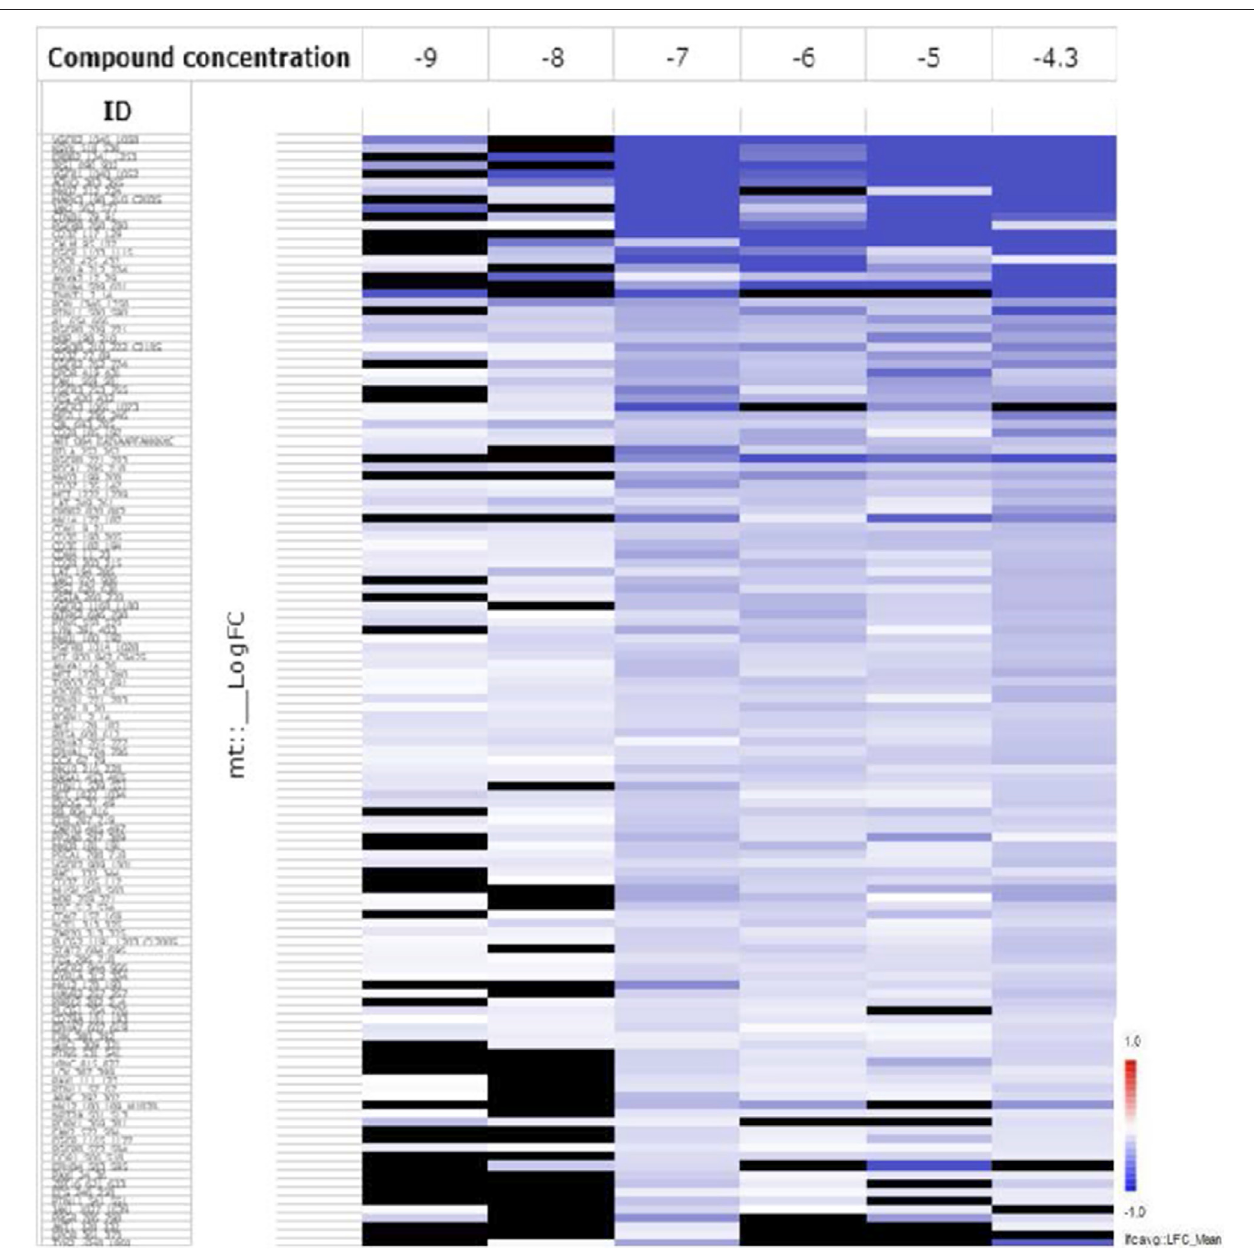
FIGURE5| TheLFCheatmapforpeptidesshowsthevaluesofdifferentiallyinhibited phosphorylated peptides (KIM-161vs.DMSOcontrol).Thetreatment effects are log-ratios [log2(treatment) − log2(control)]. Black are peptides which did not pass the threshold of inhibition. DMSO concentration 2% v/v; compound concentration log − 9 (cid:1) 0.001 μ M; log − 8 (cid:1) 0.01 μ M; log − 7 (cid:1) 0.1 μ M; log − 6 (cid:1) 1 μ M; log − 5 (cid:1) 10 μ M, and log − 4.3 (cid:1) 50 μ